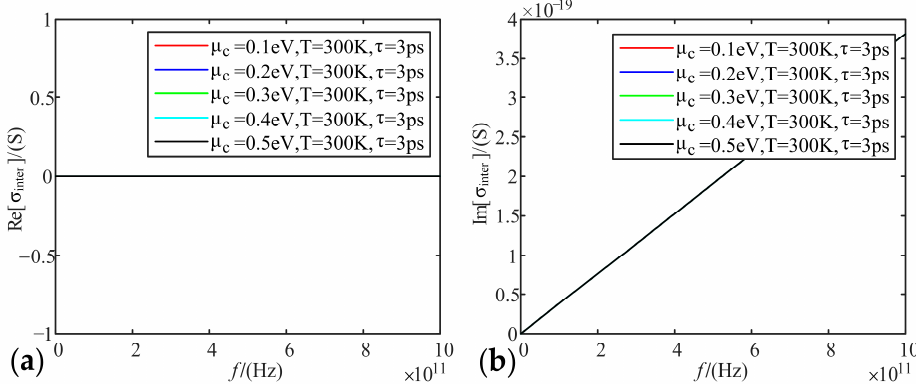
Figure 3. Variation of graphene inter-band conductivity with frequency at different electrochemical potentials: ( a ) real part; ( b ) imaginary part.